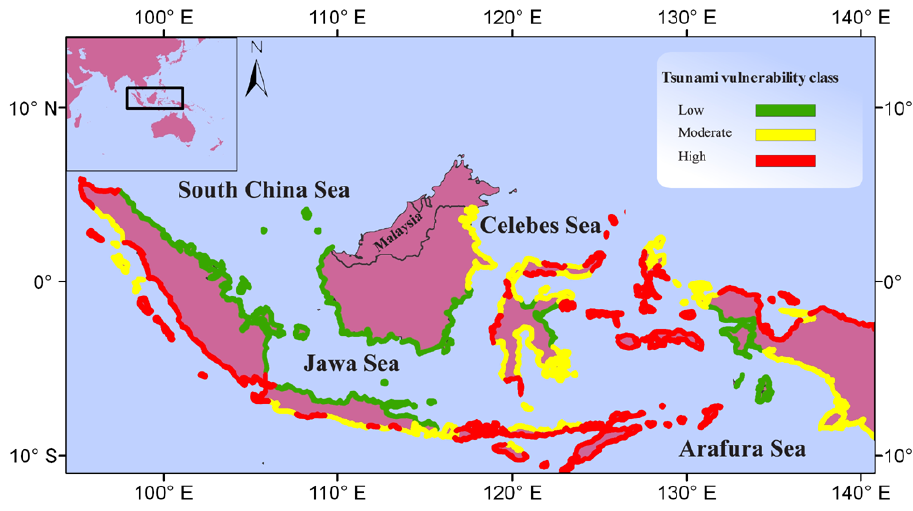
Fig. 6. Coastal vulnerable areas to tsunami in Indonesia (Compiled from those of BKSPN,